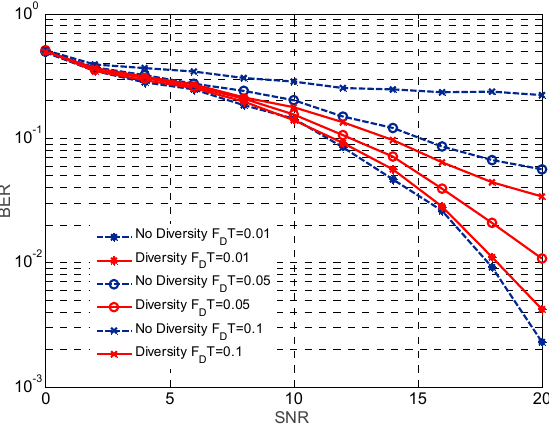
Figure 5. BER performance comparison under different F D T and with or without diversity reception.